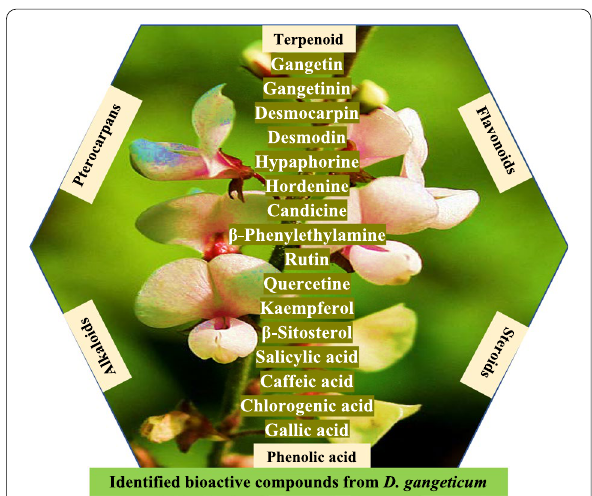
Fig. 4 Schematic diagram represents the phytoconstituents present in D.